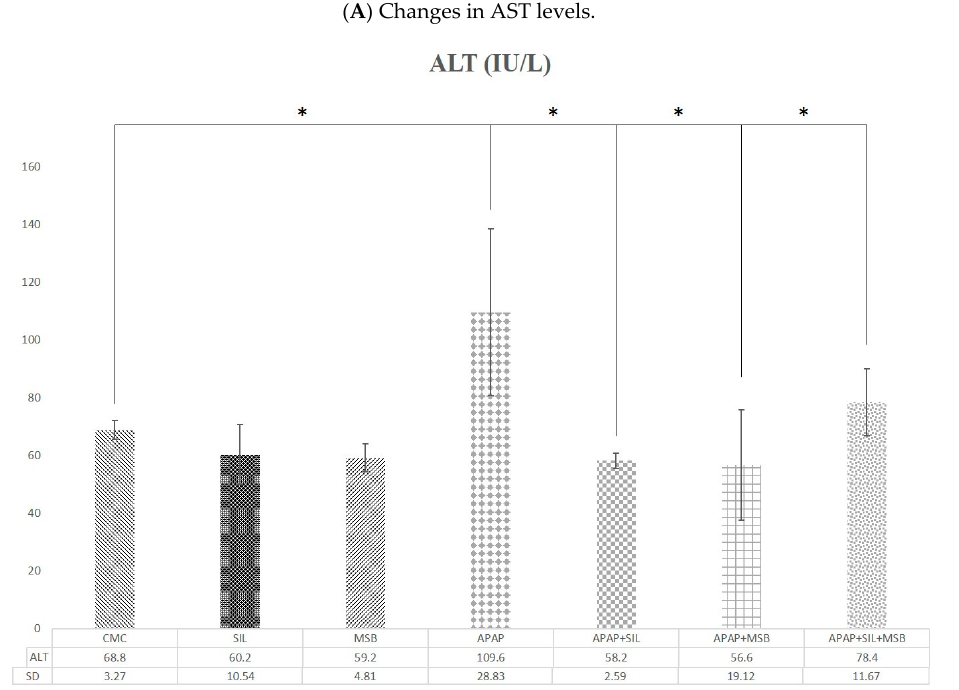
Figure 1. Changes in AST (dotted) and ALT (lined) levels. Rats were treated with 1% CMC, APAP, MSB or SIL either alone or in various combinations (as indicated). Periorbital blood was collected on Day 13, and the serum was tested for AST and ALT levels. * Significant difference ( p <0.05) between groups; data were analyzed using one-way ANOVA. Abbreviations: ALT, alanine aminotransferase; AST, aspartate aminotransferase; APAP, N-acetyl-p-aminophenol or paracetamol (acetaminophen); CMC, carboxymethylcellulose; MSB, MegaSporeBiotic™; SIL, silymarin.